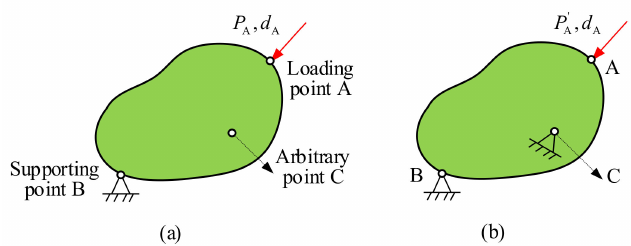
Figure 4. Simplified model of an elastic structure: ( a ) original system; ( b ) constrained